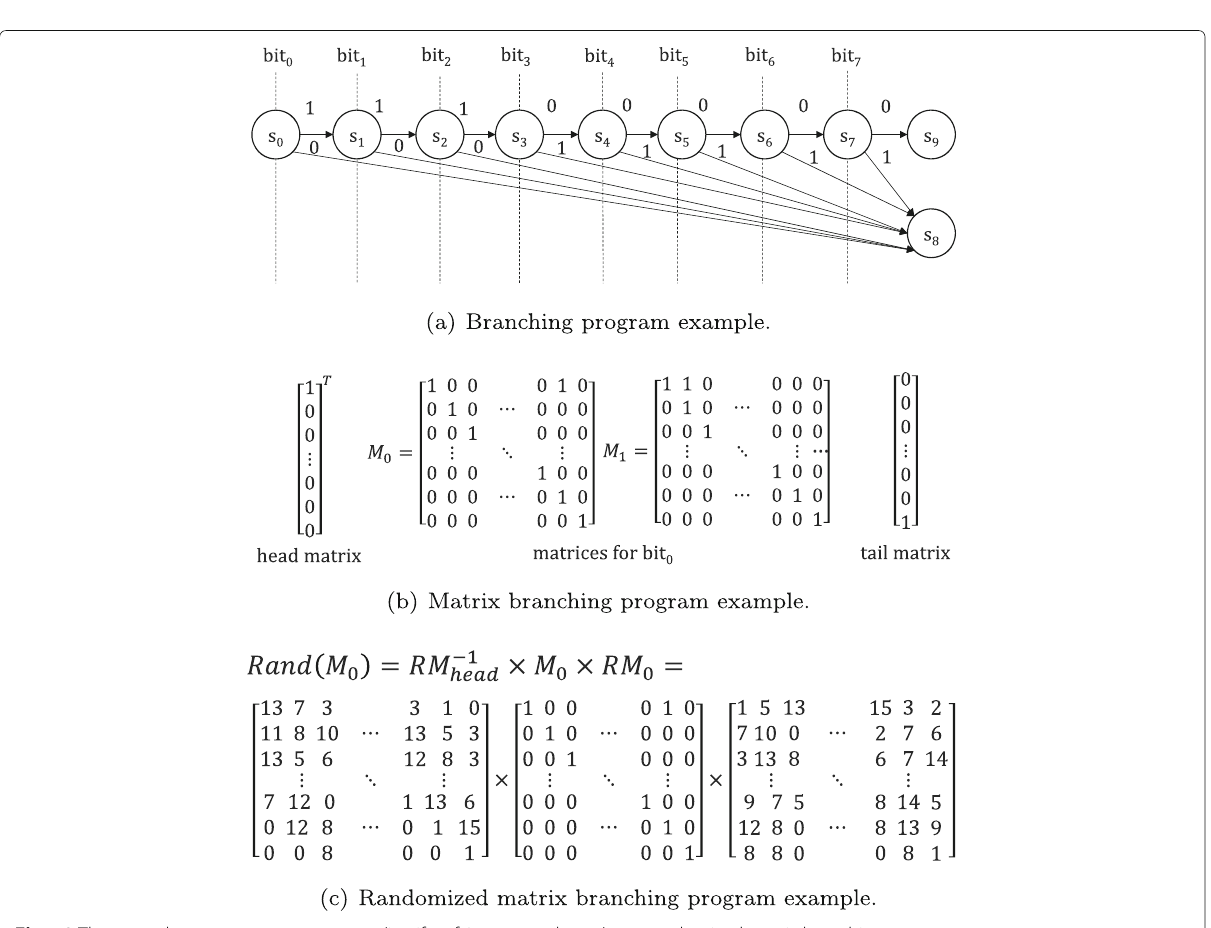
The randomization mechanism ensures that all ran- domization matrices RM i would be canceled when evalu- ating RMBP f ( x )